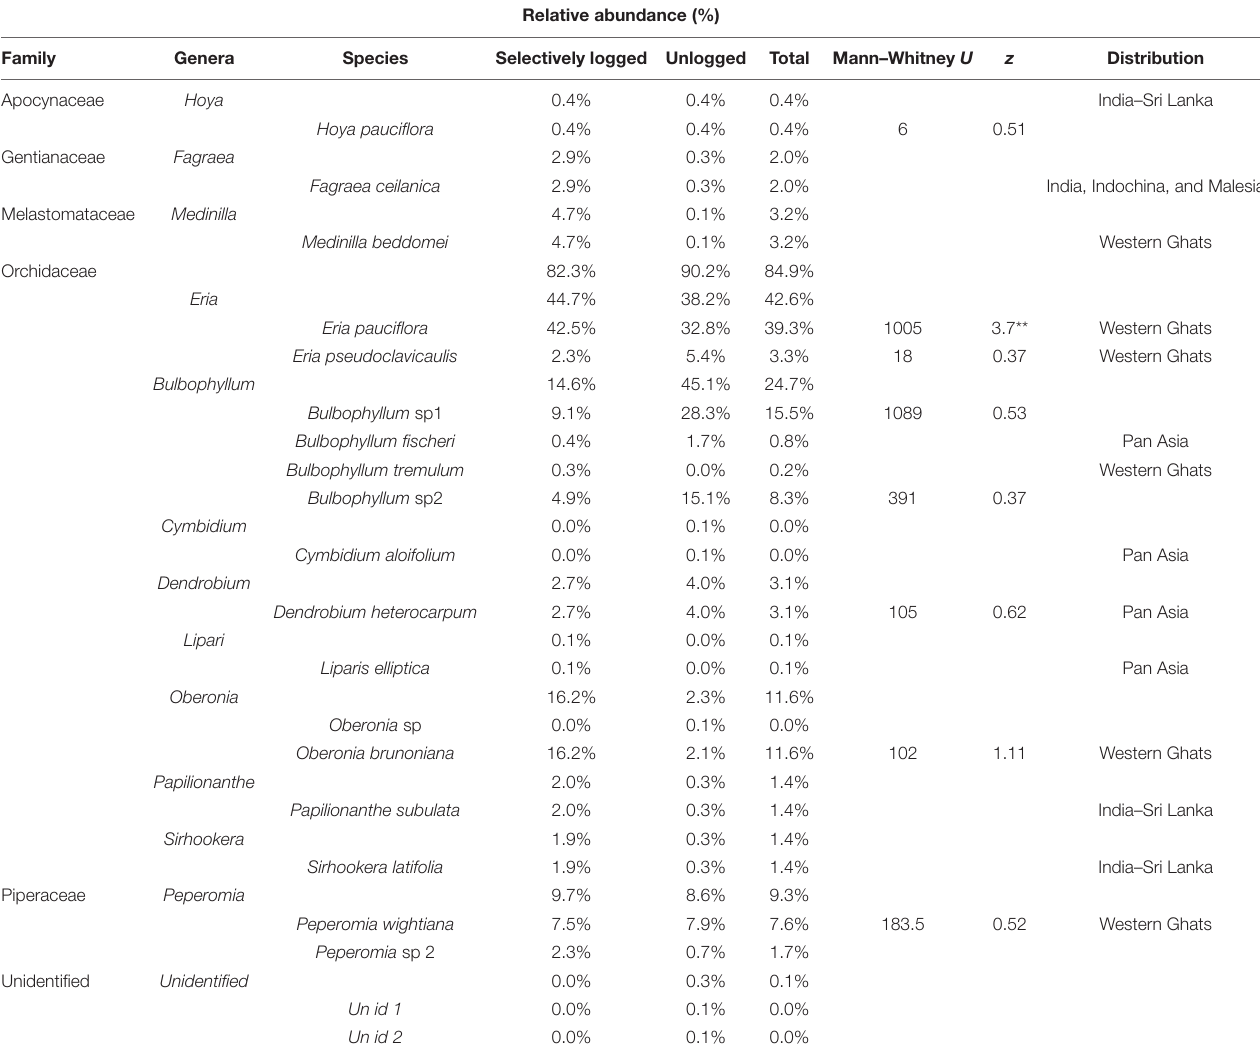
TABLE 1 | Relative abundance of vascular epiphytes encountered in the unlogged and selectively logged forests of the Kalakad Mundanthurai Tiger Reserve (KMTR). Relative abundance